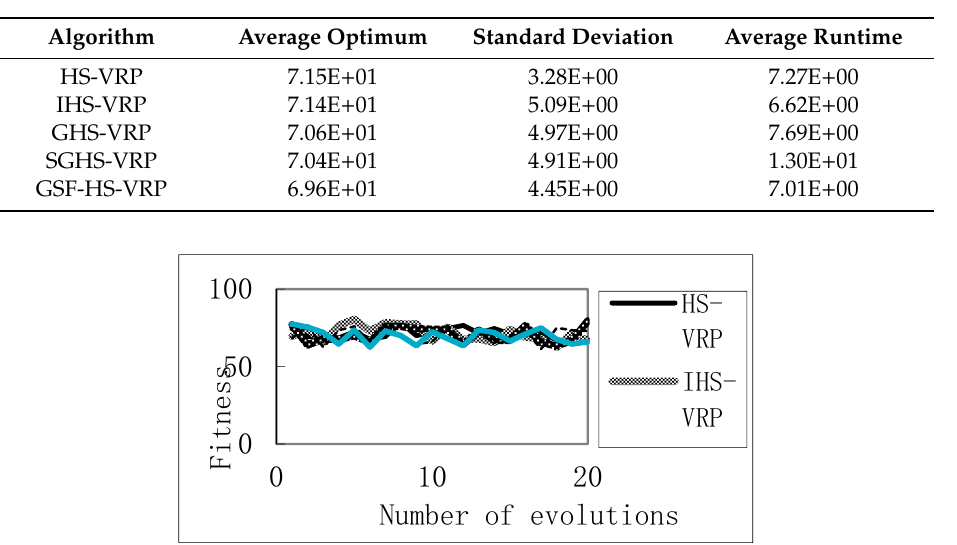
Table 2. Comparison of the results of fixed iterations. HS: Harmony Search, IHS: Improved Harmony Search, GHS: Global-best Harmony Search, SGHS: Self-adaptive Global Best Harmony Search.